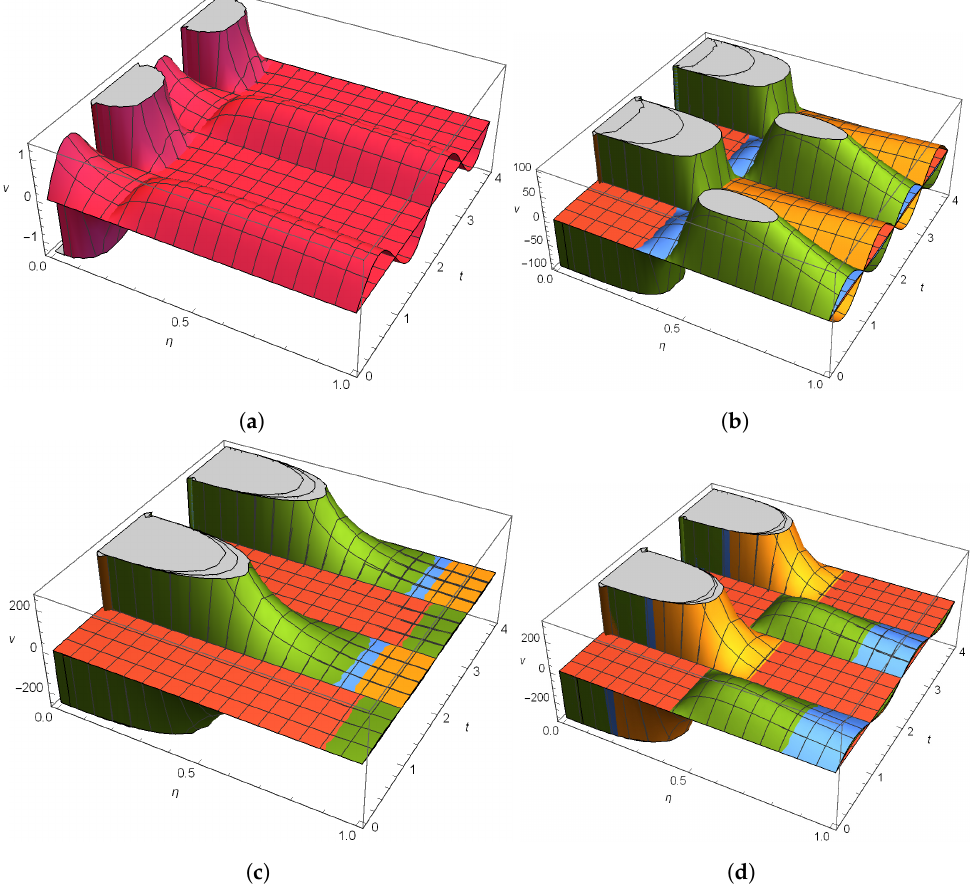
Figure 1. 3-D Plot of α -HATM solution for YAC operator with exact solution for case 1 when γ = 0.99. ( a ) α -HATM solution with exact solution. ( b ) α -HATM solution with exact solution for distinct values of k , Yellow (k = − 0.01), Blue (k = − 0.04), Green (k = − 0.08), Red (Exact Solution). ( c ) α -HATM solution with exact solution for distinct values of r , Yellow (r = 1), Blue (r = 2), Green (r = 3), Red (Exact Solution). ( d ) α -HATM solution with exact solution for distinct values of χ , Yellow ( χ = 3), Blue ( χ = 5), Green ( χ = 7), Red(Exact